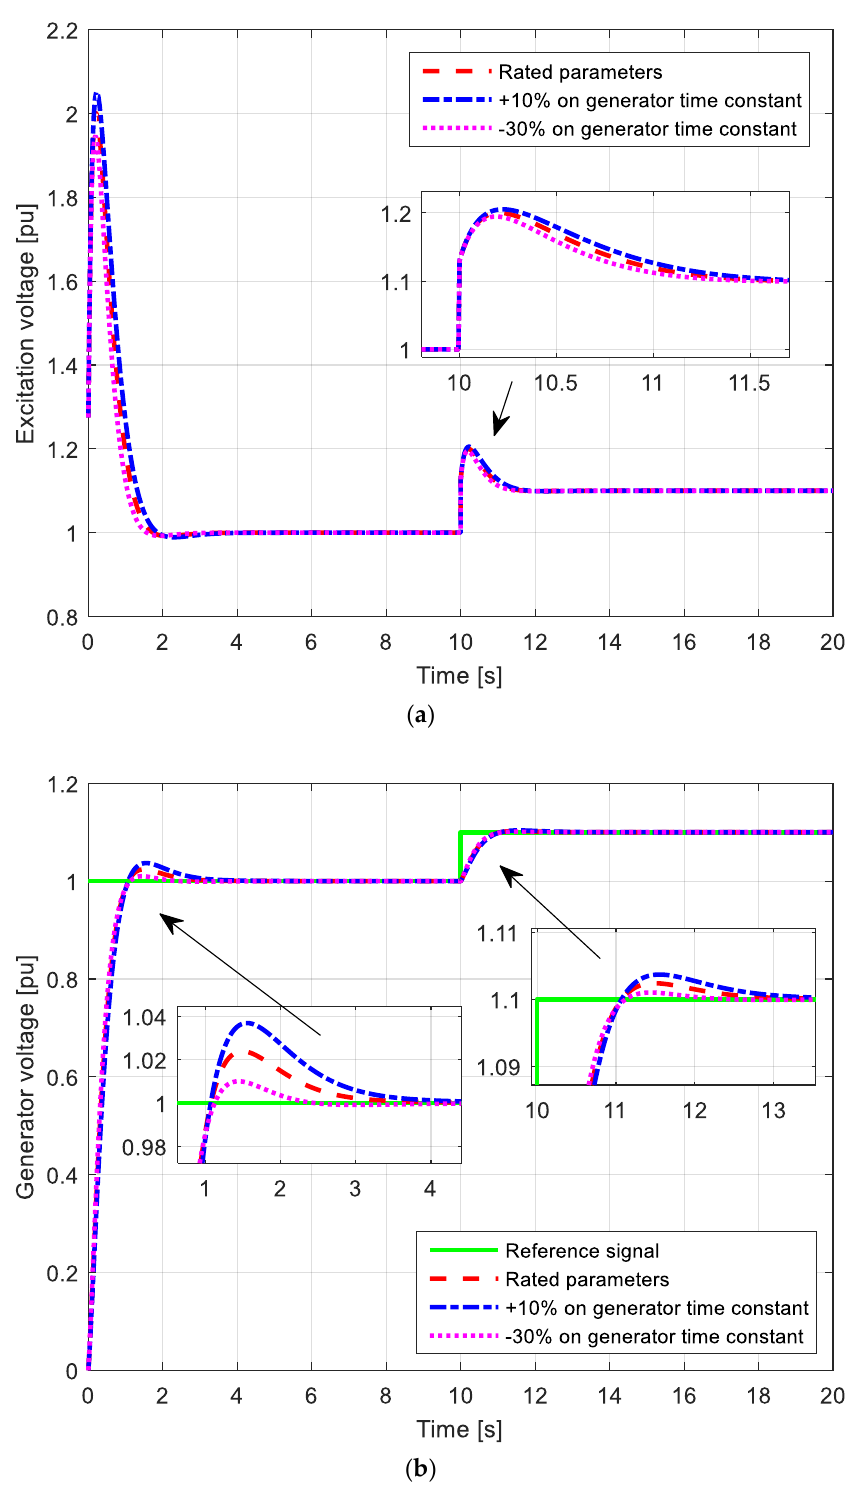
Figure 16. Time constant variation. ( a ) Excitation and ( b ) generator voltage responses.